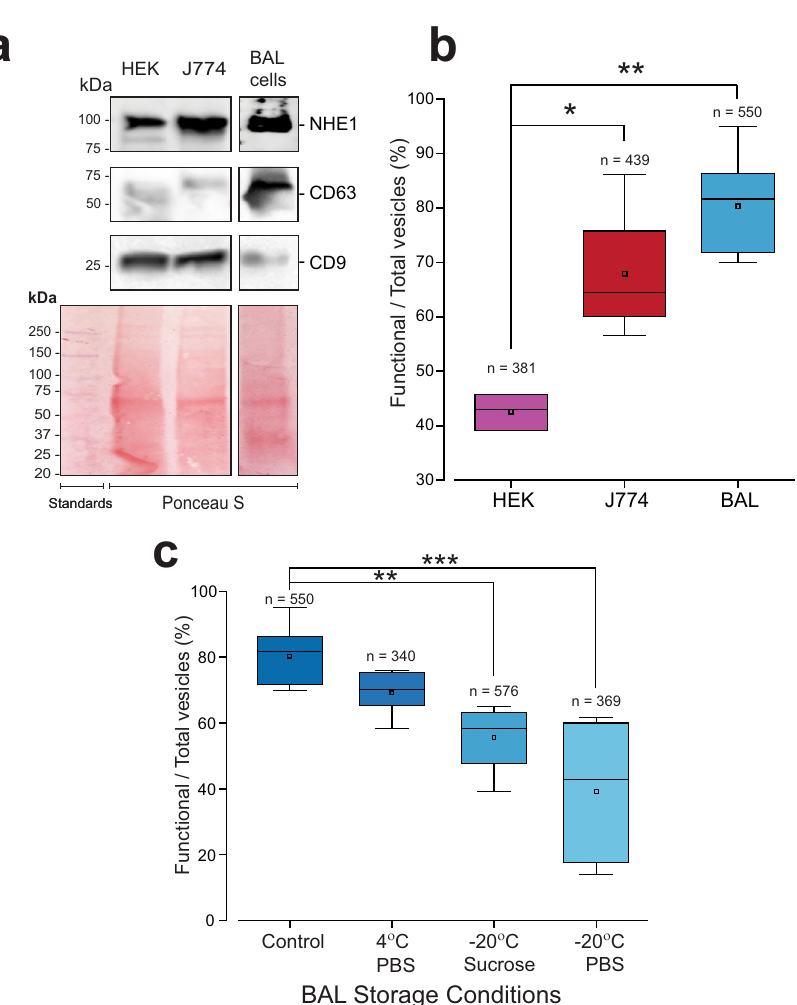
Fig. 7 EV origin and storage affect NHE1 functionality. a Western blot analysis demonstrating the expression of NHE1 on multiple cell lines used experimentally: J774, HEK, and BAL cell samples. NHE1 expression is present on all cells used in the study. Speci fi c tetraspanin expression is very dependent on cell type. CD63 is only weakly expressed on the cell lines HEK and J774. On the other hand, CD9 is weakly expressed on BAL cells but robustly expressed on the HEK and J7774 cells. b Comparative distribution of NHE1 functional vesicles as a percentage of the total population: HEK (3 chips, n = 381 individual vesicles); J774 (4 chips, n = 439 individual vesicles); BAL (8 chips, 12 EV isolations, n = 550 individual vesicles). Signi fi cance levels: * P < 0.05, ** P < 0.01 (one-way ANOVA). c EV storage affects NHE1 functionality: comparative distribution of NHE1 functional vesicles as a percentage of the total population imaged after different storage protocols: Control (8 chips, 12 EV isolations, n = 550 individual vesicles); 4 °C PBS (5 chips, 10 EV isolations, n = 340 individual vesicles); − 20 °C Sucrose (7 chips, 3 EV isolations, n = 576 individual vesicles); − 20 °C PBS (5 chips, 2 EV isolations, n = 369 individual vesicles). Signi fi cance levels: ** P < 0.01, *** P < 0.001 (one-way